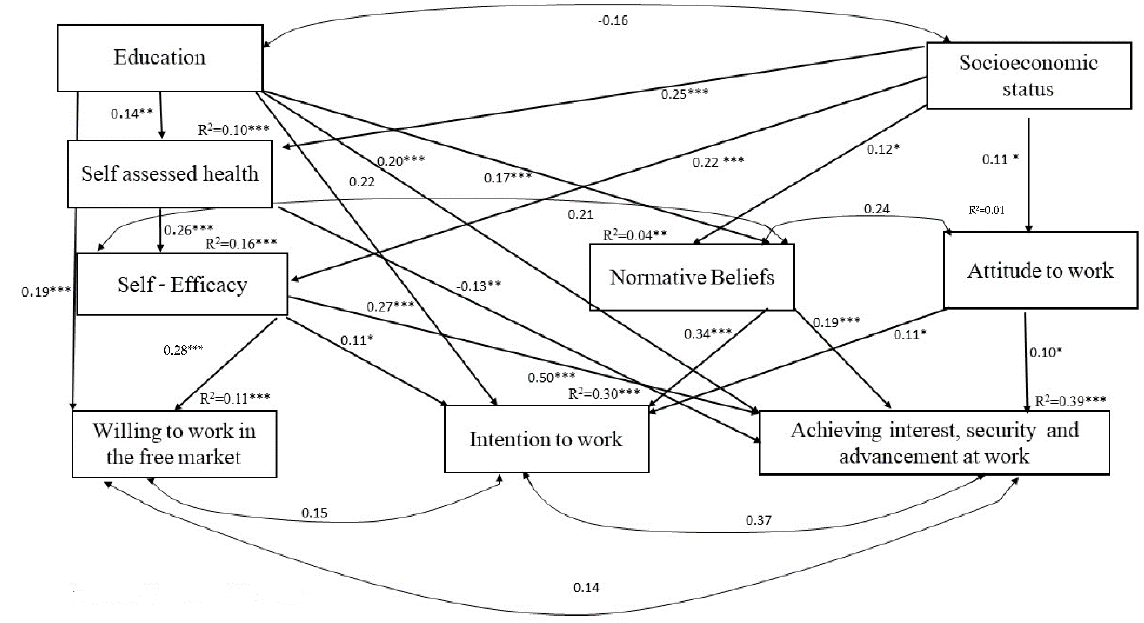
Figure 1. The path analysis model with significant effects and correlations (i.e., standardized path coefficients) between the variables. * p < 0.05, ** p < 0.01, *** p < 0.001.